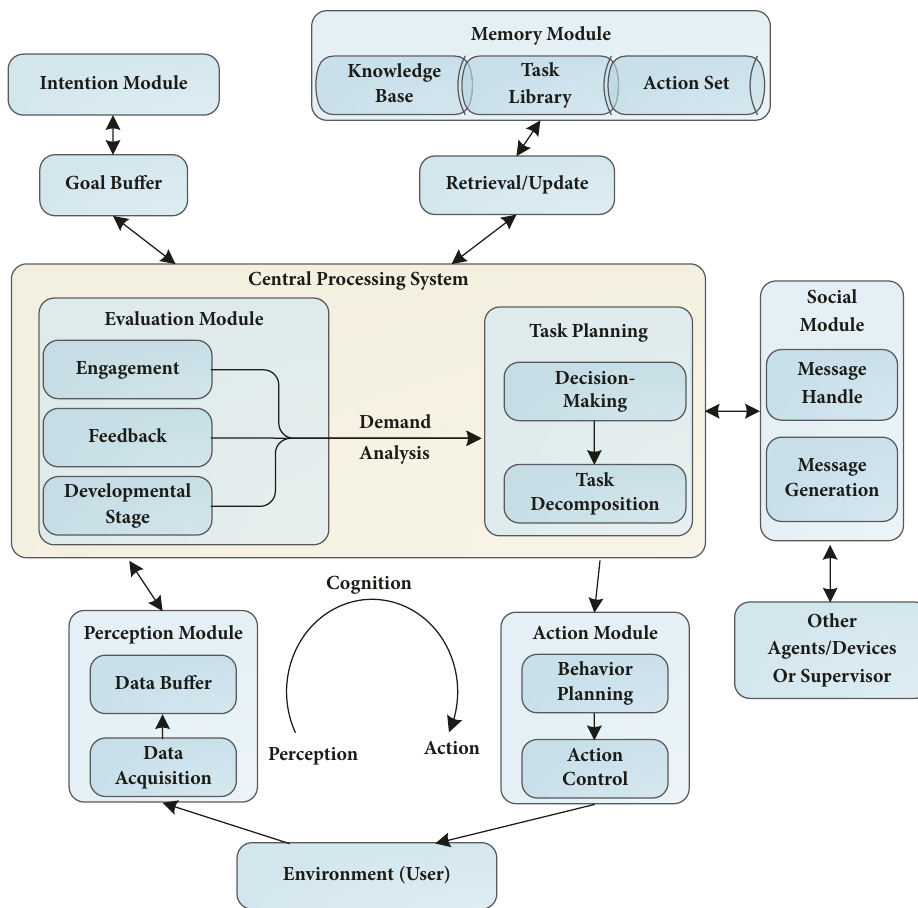
Figure 5: The control architecture of the robot for autism intervention (CARAI).